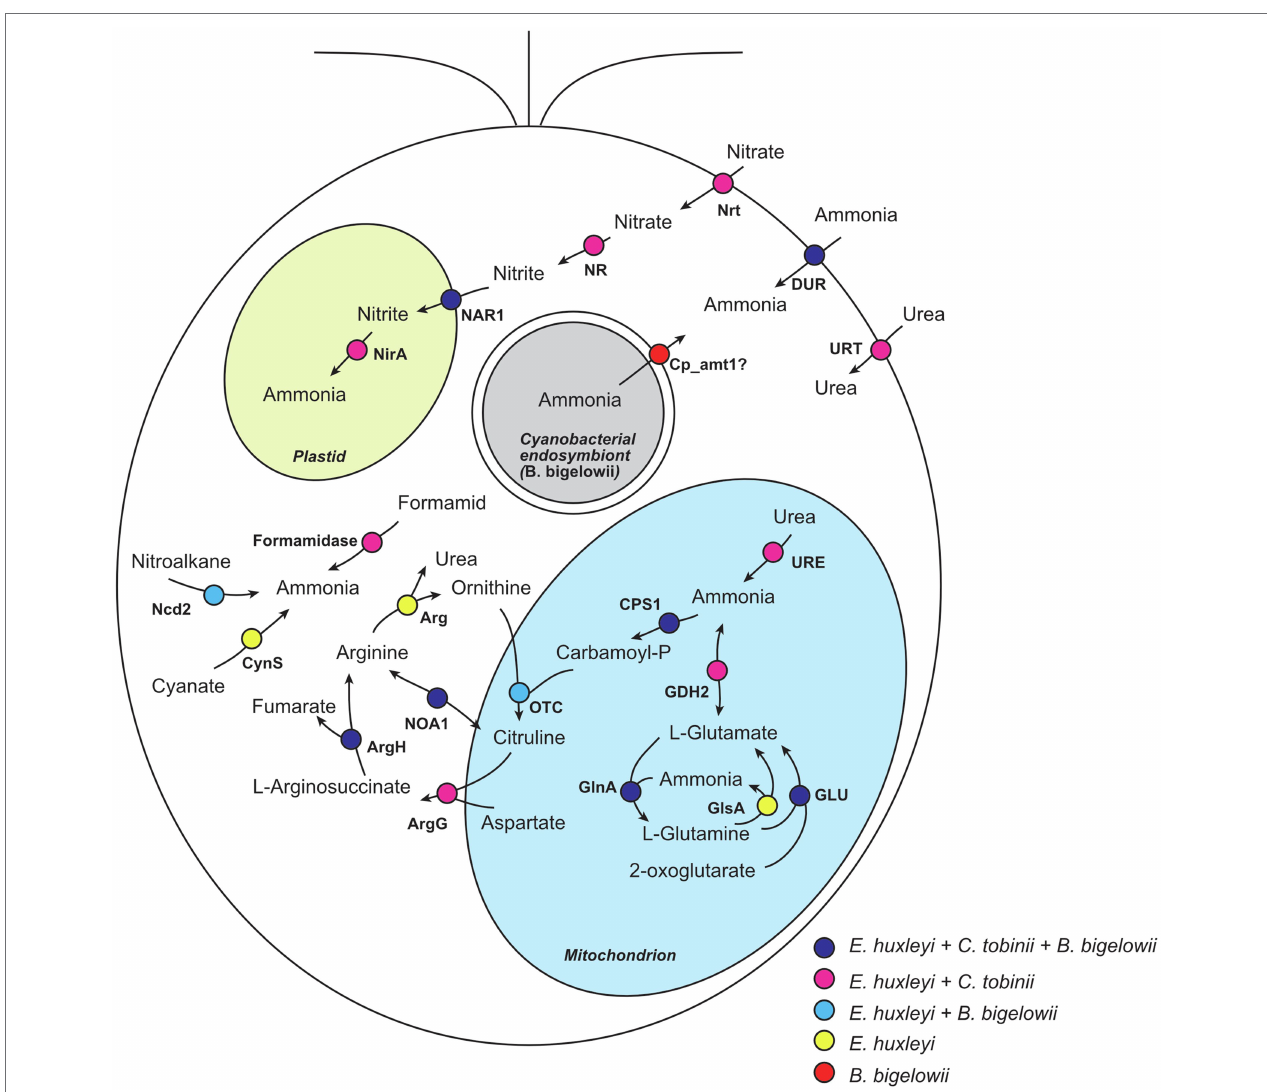
FIGURE 4 | Nitrogen metabolism in haptophytes. Nitrogen metabolism was predicted based on the genome of E. huxleyi . Proteins encoded in the genomes of E. huxleyi and C. tobinii , and the transcriptome of B. bigelowii is shown. Circles with different colors represent proteins shared among different species. Nrt, nitrate transporter; NR, nitrate reductase; NAR1, formate/nitrite transporter; NirA, ferredoxin-nitrite reductase; Ncd2, nitronate monooxygenase; CynS, cyanate lyase; DUR, ammonia transporter; URT, urea transporter; URE, urease; GDH2, glutamate dehydrogenase; GLU, glutamate synthase; GlsA, glutaminase; GlnA, glutamine synthetase; CPS1, carbamoyl-phosphate synthase; OTC, ornithine carbamoyltransferase; ArgG, argininosuccinate synthase; ArgH, argininosuccinate lyase; NOA1, nitric-oxide synthase; and Arg,